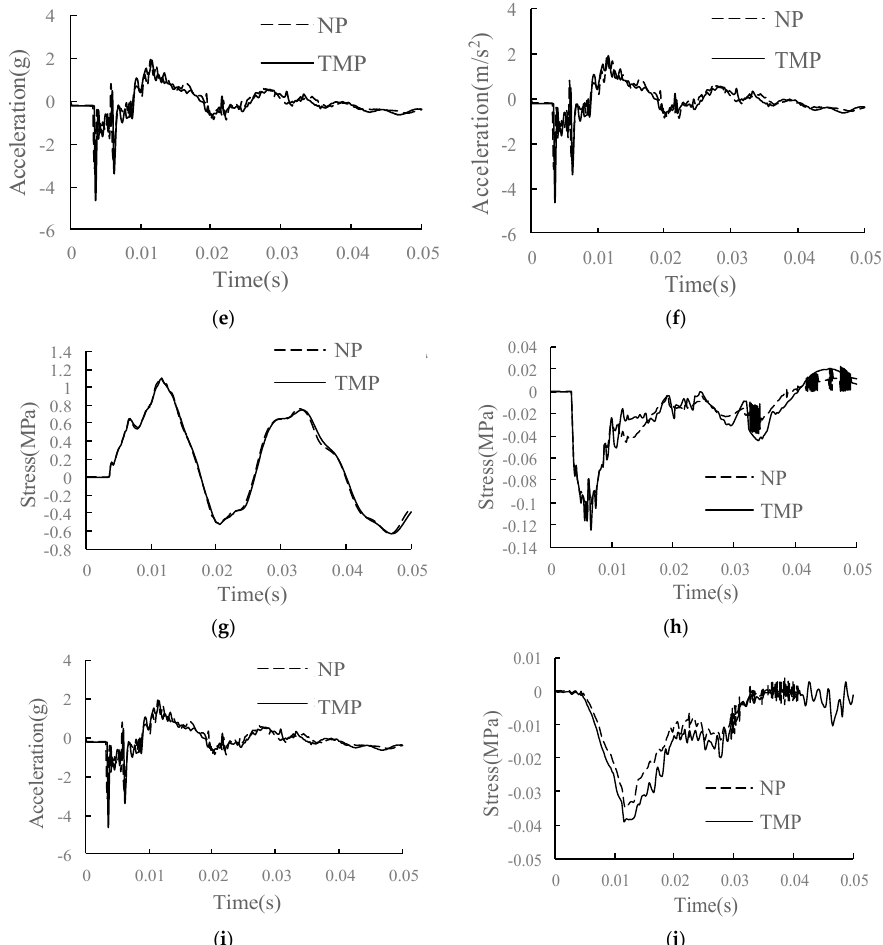
Figure 23. Dynamic response diagram of each structural layer in the condition of TMP: ( a ) wheel–rail vertical force; ( b ) rail acceleration; ( c ) rail vertical speed; ( d ) rail vertical displacement; ( e ) track slab acceleration; ( f ) acceleration of SCC layer; ( g ) longitudinal stress of SCC layer; ( h ) vertical stress of SCC layer; ( i ) base acceleration; ( j ) vertical stress of substructure.